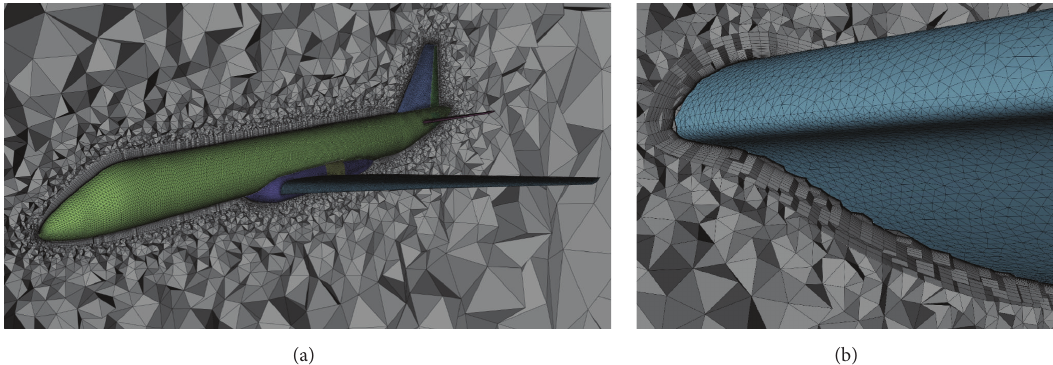
Figure 6: 3D hybrid mesh for RANS computation around complete aircraft w/o engine (a) and around the morphing leading edge